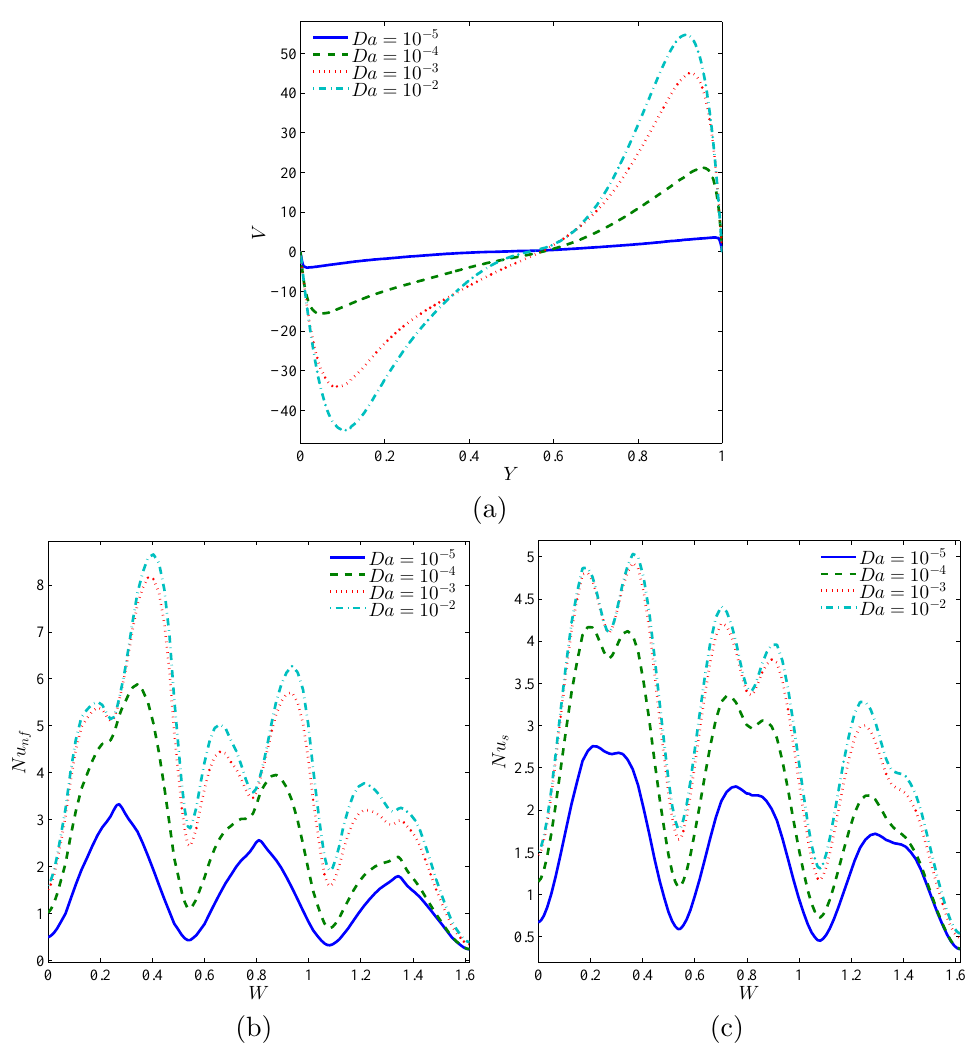
Figure 6. Local velocity ( a ), the local Nusselt number of the nanofluid phase ( b ), and the local Nusselt number of the solid phase ( c ) with the vertical line ( Y ) for X = 0.5 for different Da values; φ = 0.02, γ = 10, A = 0.1, and ε =